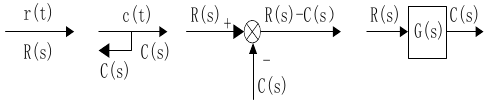
Figure 1. Structure diagram of control system four